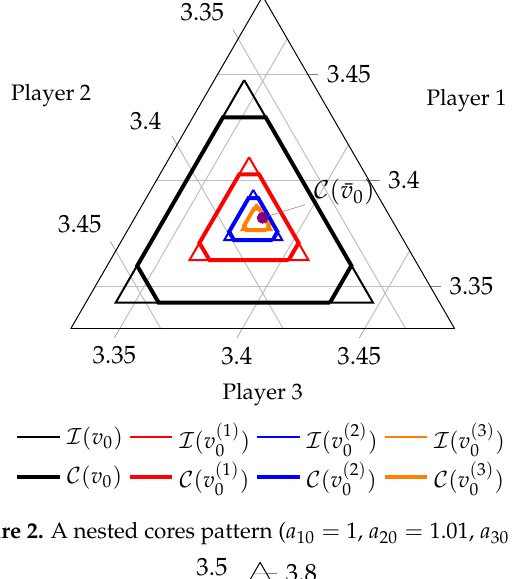
Figure 1. A non-empty intersection of the original core and the modified core ( a 10 = 1, a 20 = 1.1, a 30 = 1).